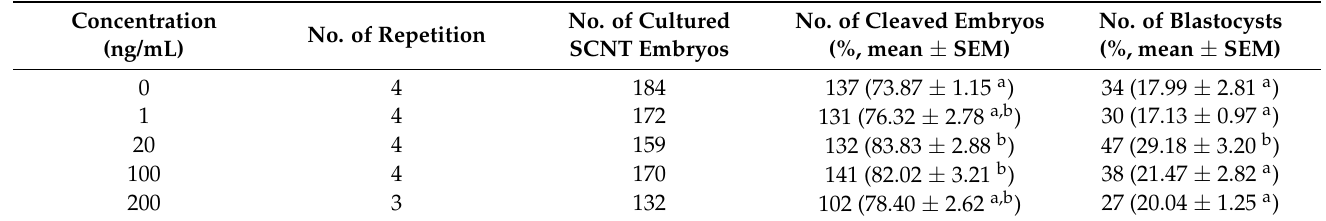
Table 2. Effects of supplementation of SDF1 during porcine oocyte IVM on subsequent development of SCNT embryos.